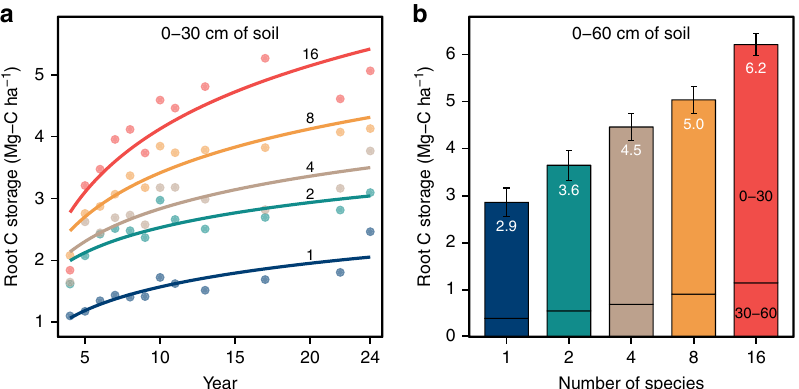
Fig. 2 Change in root C over 24 years. a Change in root C in upper 30 cm of soil under different experimentally imposed levels of plant species diversity. Dots indicate mean root C at a given year; curves fi tted with log functions; the number on each curve indicates plant species diversity. b Total root C storage after 24 years of growth in upper 60 cm of soil. Numbers in white indicate mean total root C storage, error bars indicate standard errors,